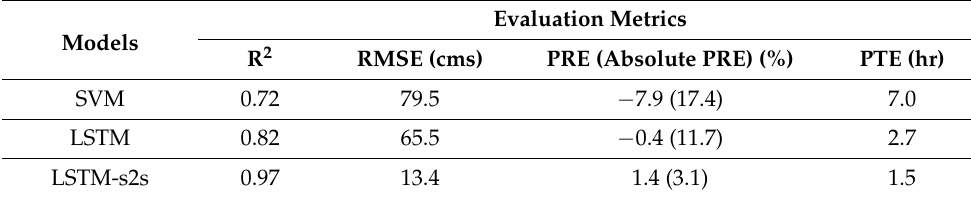
Table 1. Mean values of evaluation metrics for simulated hydrograph